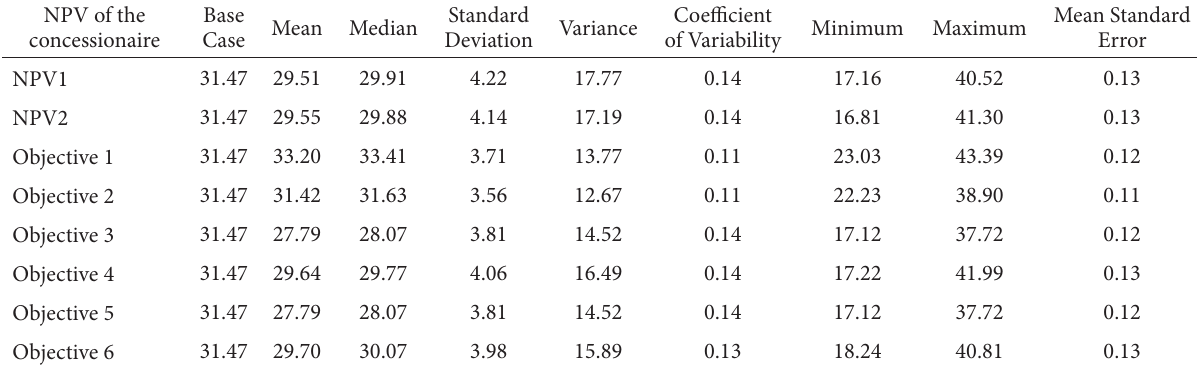
Table 4. Comparisons of the government’s NPV under different cases (in million EUR) NPV of the